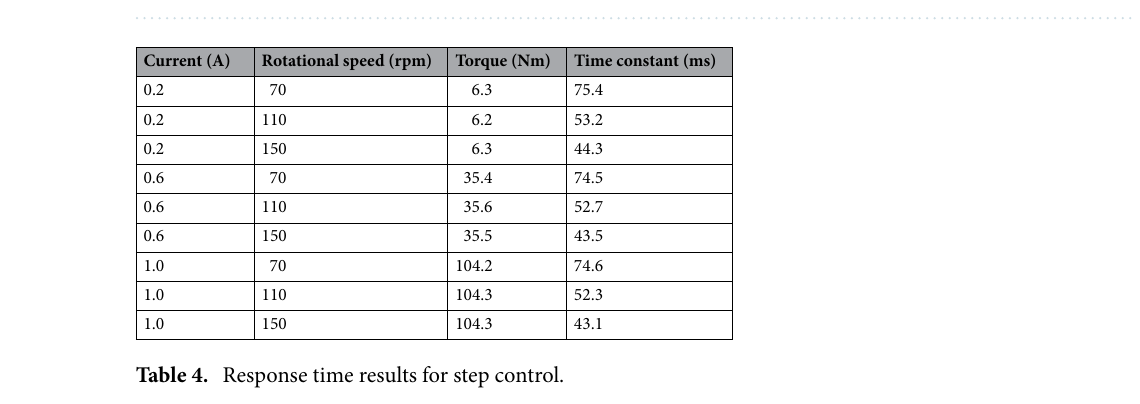
Figure 10. Transient torque versus time when the current is turned on at 2 s and turned off at 5 s. ( a ) Torque versus rising time; ( b ) torque versus falling time.